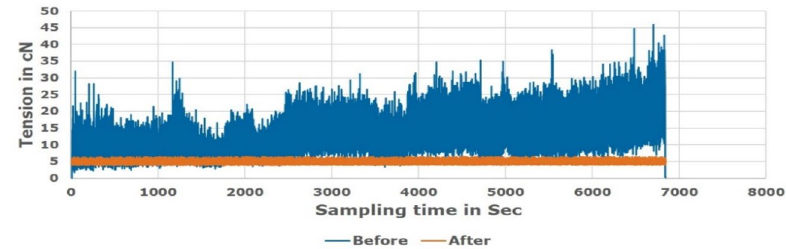
Figure 20. Unwinding tension before and after proposed system for Ne 40 polyester yarn.